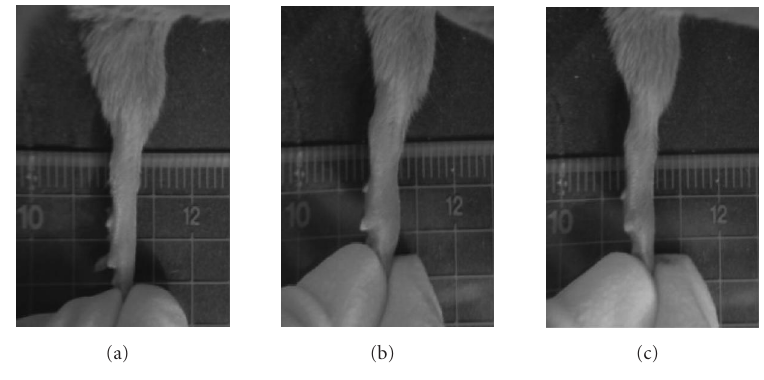
Figure 2: Typical swelling of control mice and that of geranium-treated mice. Nontreated foot (a), carrageenan injected control (b), and geranium-treated (c) feet 24 hours after carrageenan injection were shown. The mouse was administered with geranium oil 10 minutes after carrageenan injection.